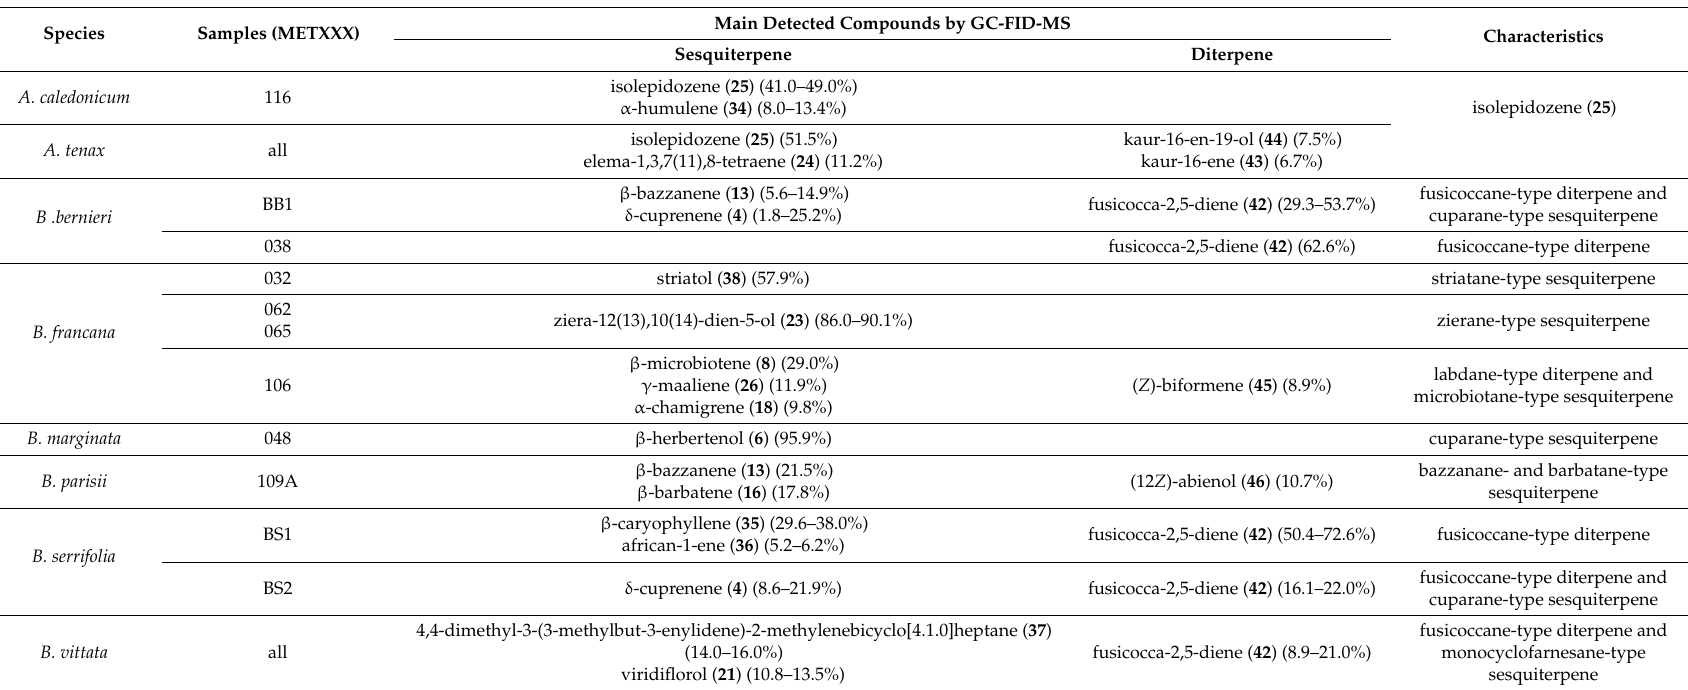
Table 7. Main constituents of studied Bazzanioideae